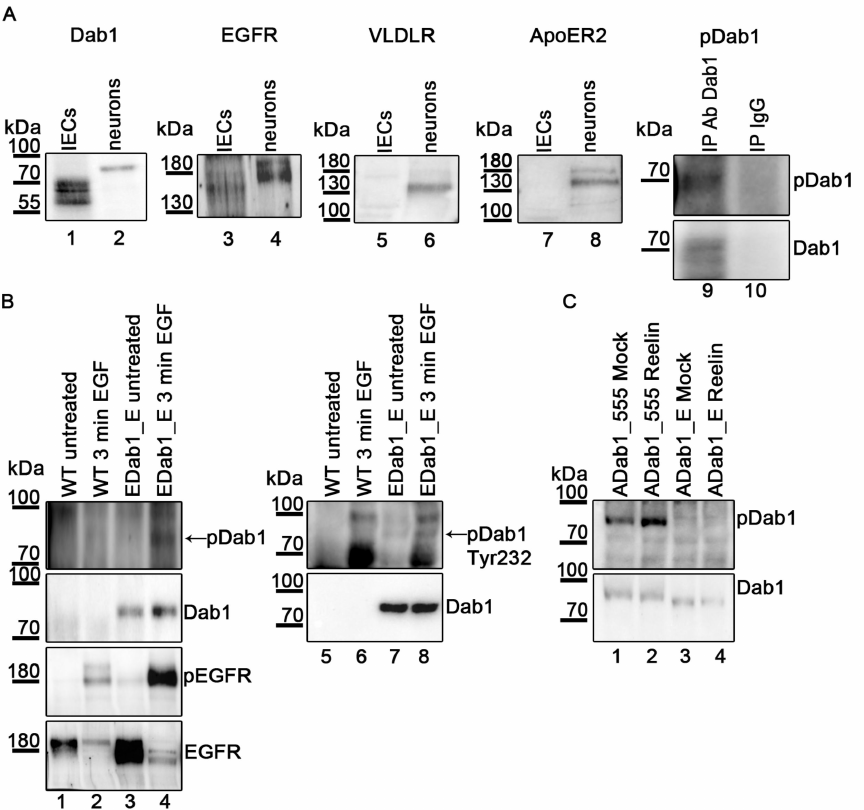
Figure 7. EGF induces phosphorylation of the Dab1 Early isoform. ( A ) Embryonic primary neurons (DIV3) and intestinal epithelial cells (IECs) were lysed and the protein extracts were analyzed by western blotting for expression of Dab1 (Lanes 1 and 2), EGFR (Lanes 3 and 4), VLDLR (Lanes 5 and 6), and ApoER2 (Lanes 7 and 8). Phosphorylation level of Dab1 in IECs was analyzed by Dab1 immunoprecipitation and probing eluates samples with phosphotyrosine specific antibody (Lanes 9 and 10, Panel 1). Blot was stripped and re-probed with a Dab1 specific antibody (Lanes 9 and 10, Panel 2). As negative control unrelated mouse IgG was used. ( B ) Western blot analysis of HEK293 cells (Lanes 1 and 2) and HEK293 cells overexpressing EGFR and chDab1_E (Lanes 3 and 4). Cells were either left untreated (Lanes 1 and 3) or treated with human EGF (10 ng/mL) for 3 min (Lanes 2 and 4). Immunoprecipitation using a Dab1 specific antibody (Ab 54) was performed. Dab1 phosphorylation levels (Panel 1, Lanes 1–4) were detected using an antibody against phosphorylated tyrosine residues (Ab PY99). The blot was stripped and re-probed for Dab1 using Ab D4 (Panel 2). Extracts were blotted with an antibody specific for EGFR phosphorylation (Panel 3, Lanes 1–4) and total levels of EGFR (Panel 4, Lanes 1–4). Extracts were also blotted with an antibody specific for Dab1 phosphorylation (Tyr 232) (Panel 1, Lanes 5–8). The blot was stripped and then re-probed with a Dab1 specific antibody (Panel 2, Lanes 5–8). ( C ) Western blot analysis of HEK293 cells expressing ApoER2 and Dab1_555 (Lanes 1 and 2) or chDab1_E (Lanes 3 and 4). Cells were either treated with Reelin (Lanes 2 and 4) or Mock conditioned medium (Lanes 1 and 3) for 20 min. Immunoprecipitation using a Dab1 specific antibody was performed (Ab 54). Dab1 phosphorylation levels (Panel 1) were detected using an antibody against phosphorylated tyrosine residues (Ab PY99). The blot was stripped and re-probed for Dab1 using Ab D4 (panel